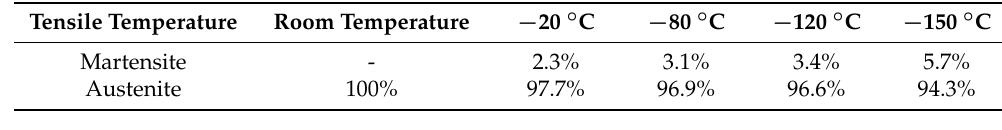
Table 1. Phase quantification of austenite and martensite by the Rietveld method.